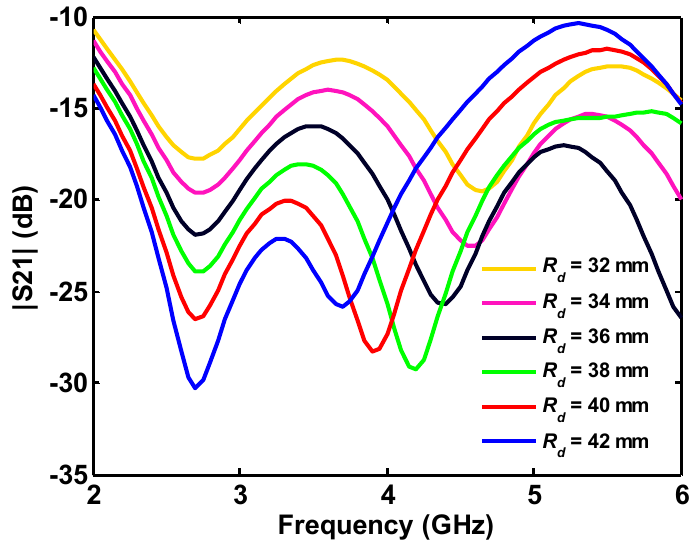
Figure 10. Effect of the inner radius of the ground plane sector on simulated insertion loss. Figure 10. E ff ect of the inner radius of the ground plane sector on simulated insertion